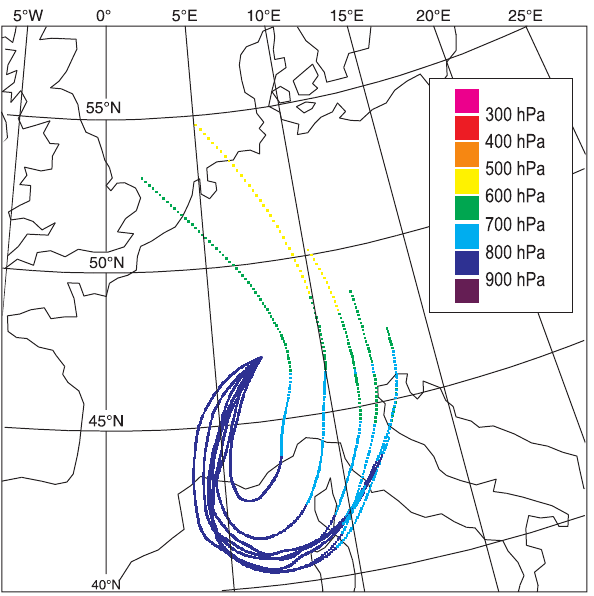
Fig. 10. 72-h backward trajectories from FLEXTRA/ECMWF ar- riving at Kerzersmoos at the 850 hPa level every 6 hours between 10 February 1998, 18 UTC and 12 February 1998, 12 UTC.